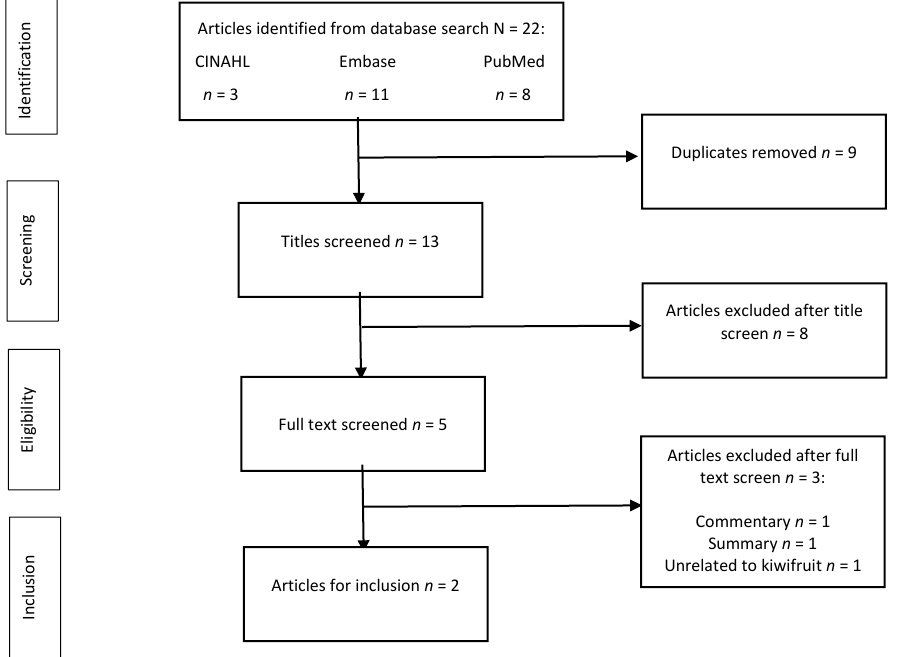
Figure 1. PRISMA flow diagram of rapid review.